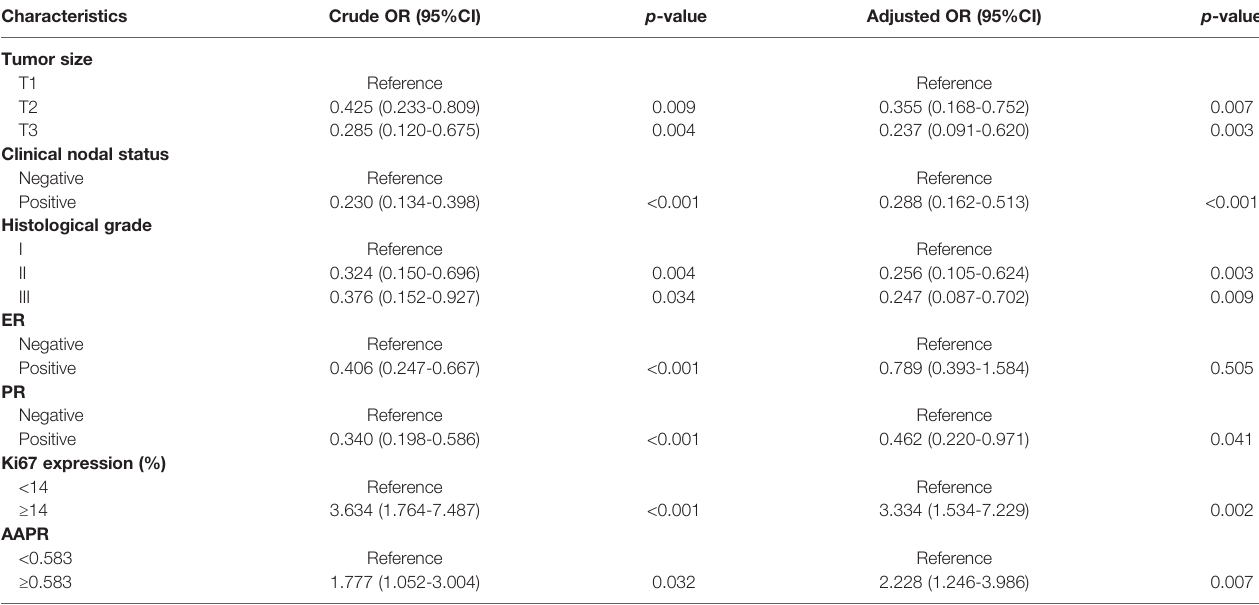
TABLE 4 | Multivariate analysis for factors associated with pCR in the training cohort. Characteristics